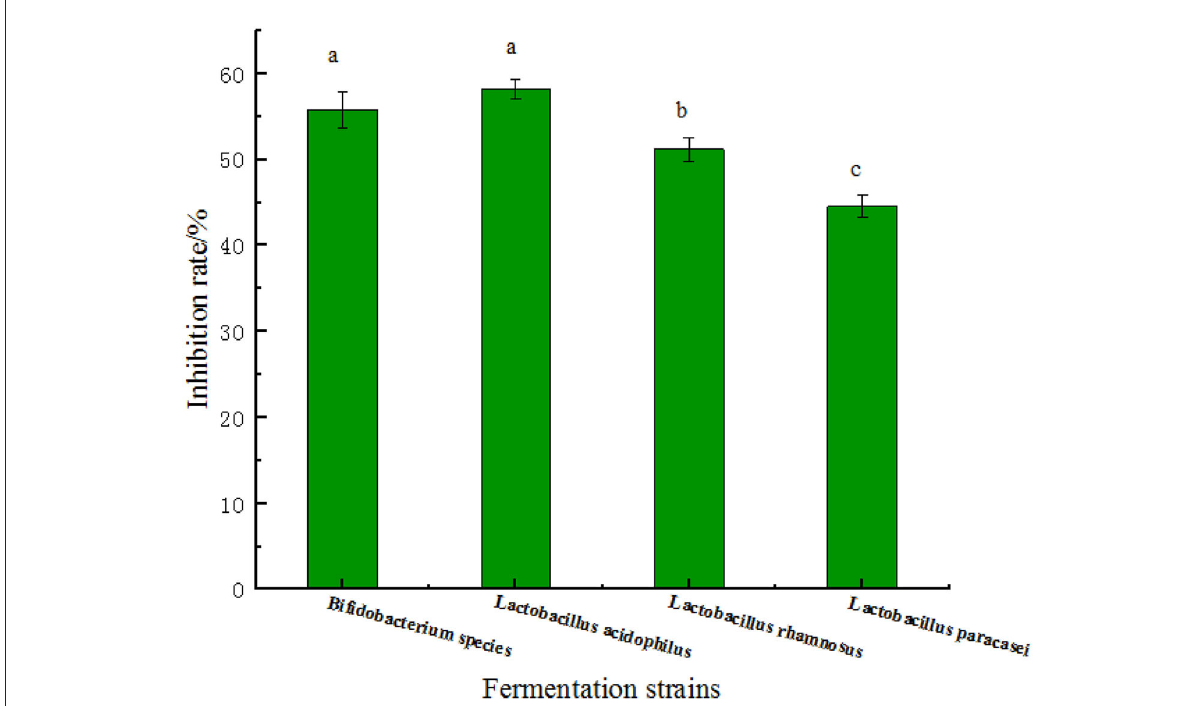
FIGURE5 The rate of α -glucosidase inhibition by four fermentation peptides of strains at the concentration of 5.0 mg/ml. Values are presented as the mean of three replicates ± standard deviation. Different letters denotes significant differences among samples ( p -value ≤